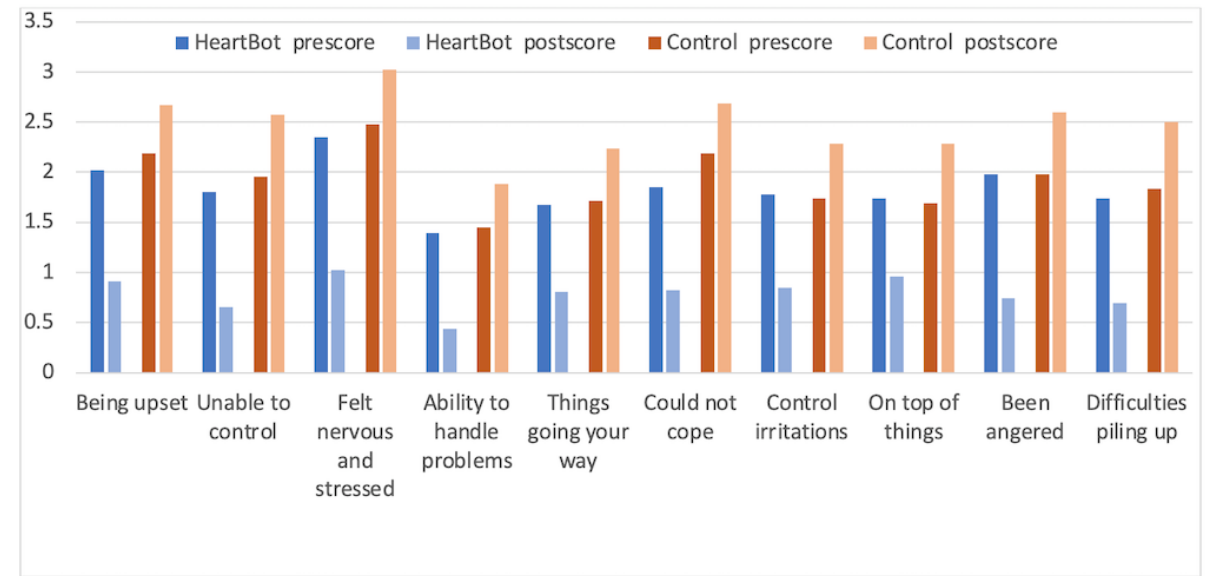
Figure 5. Summary of statistics on items on the Perceived Stress Scale survey.